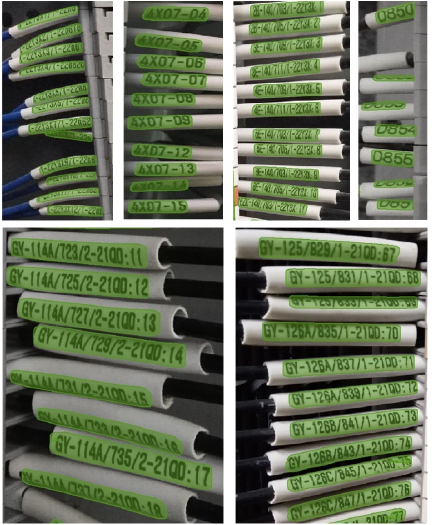
Figure 7. Some other detection results of the Rwin-FPN++